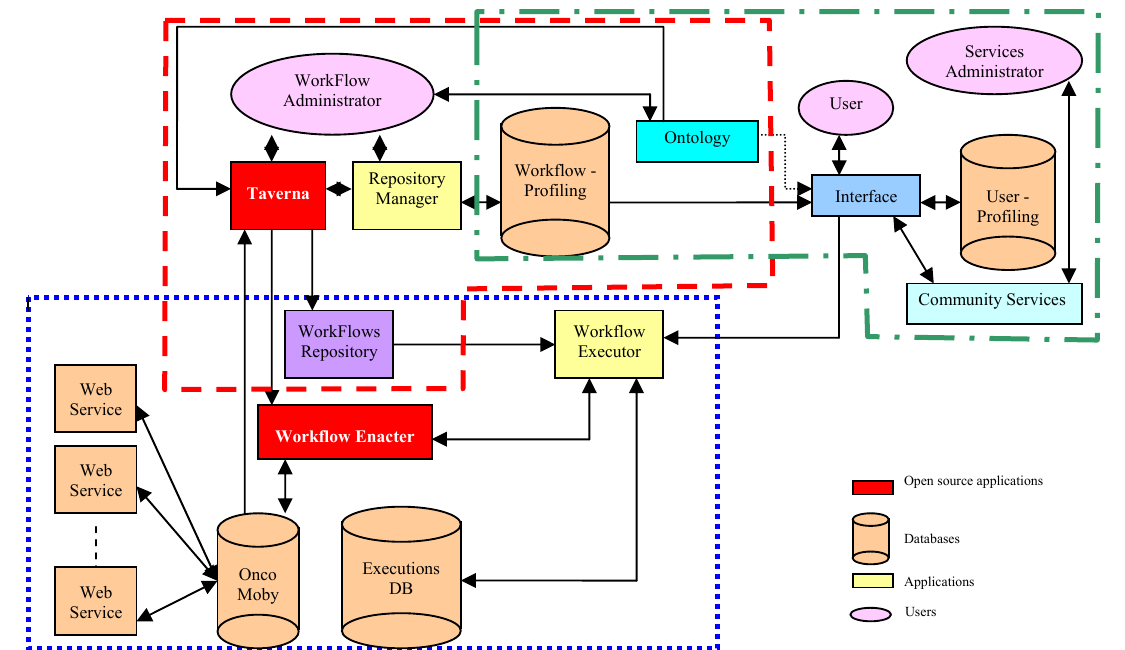
Figure 1: General schema of the Oncology over Internet (O parts: a) workflows creation and annotation, that are performed by a special user, the workflow administrator (red dashed line), b) user interface (green dot-dashed line), and c) workflows execution (blue dotted